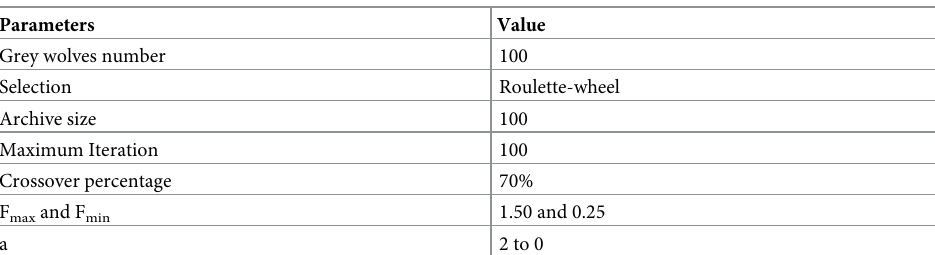
Table 4. Parameters used by